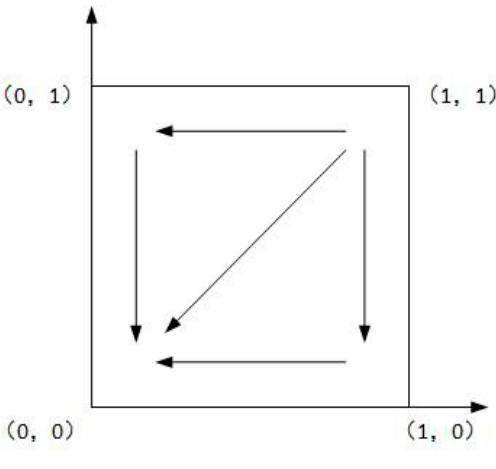
Figure 4. Phase diagram of Case 4.